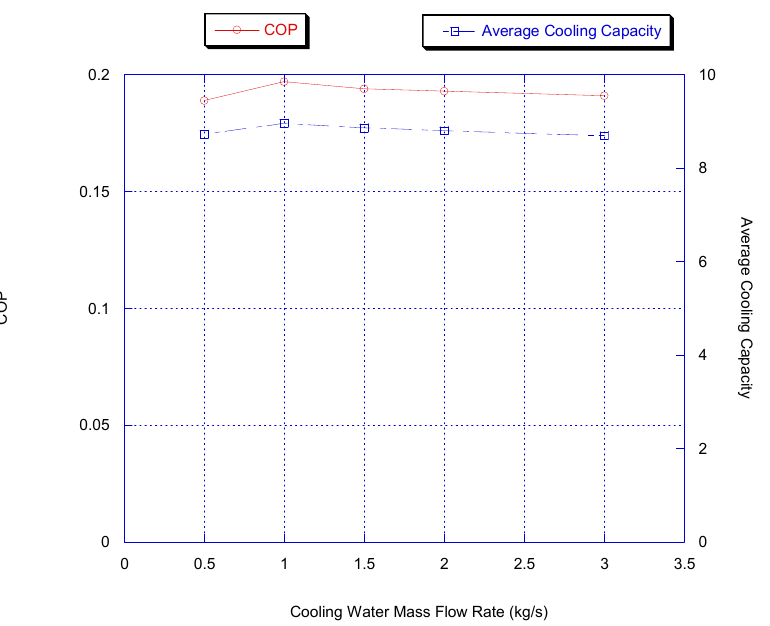
Figure 7. Effect of cooling water flow rate on chiller average cooling capacity and COP (results are chiller nominal operating conditions, shown in Appendix B). at chiller nominal operating conditions, shown in Appendix B). For this chiller, it is shown that the cooling water mass flow rate of 1 kg/s is the optimum, and so there is no need to increase it during the chiller operation.